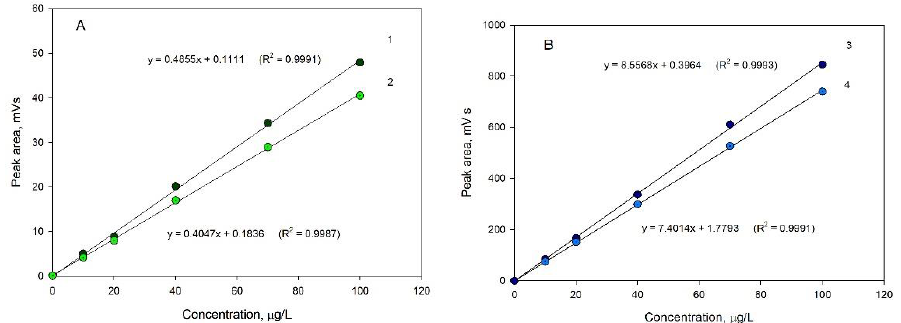
Figure 6. Peak area of dependencies on preconcentrations of aliphatic ( A ) and aromatic ( B ) hydrocarbons found by using dynamic gas extraction combined with capillary GC. 1—benzene, 2—toluene, 3—n-hexane, and 4—n-heptane.